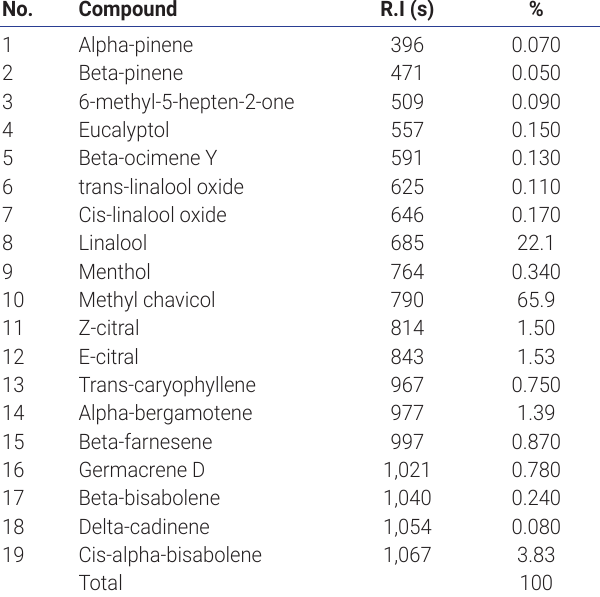
Table 1. Chemical composition of basil oil ( Ocimum basilicum